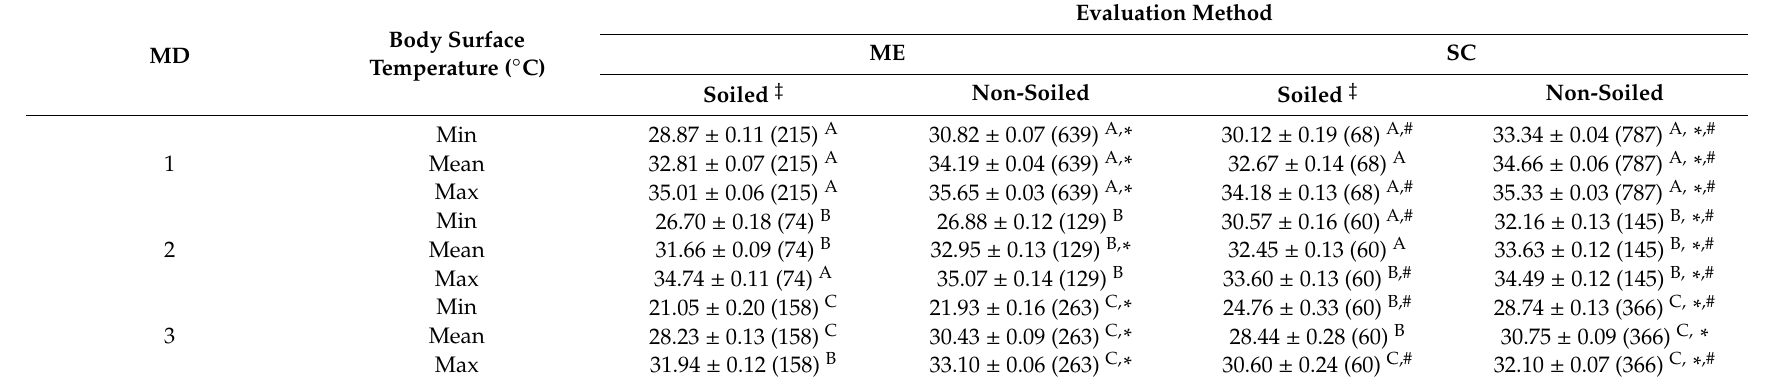
Table 3. Body surface temperature (mean ± SE ( n )) of soiled and non-soiled fattening pigs determined by evaluation method ME (maximal ellipse) and SC (standardized circle) on three measurement days